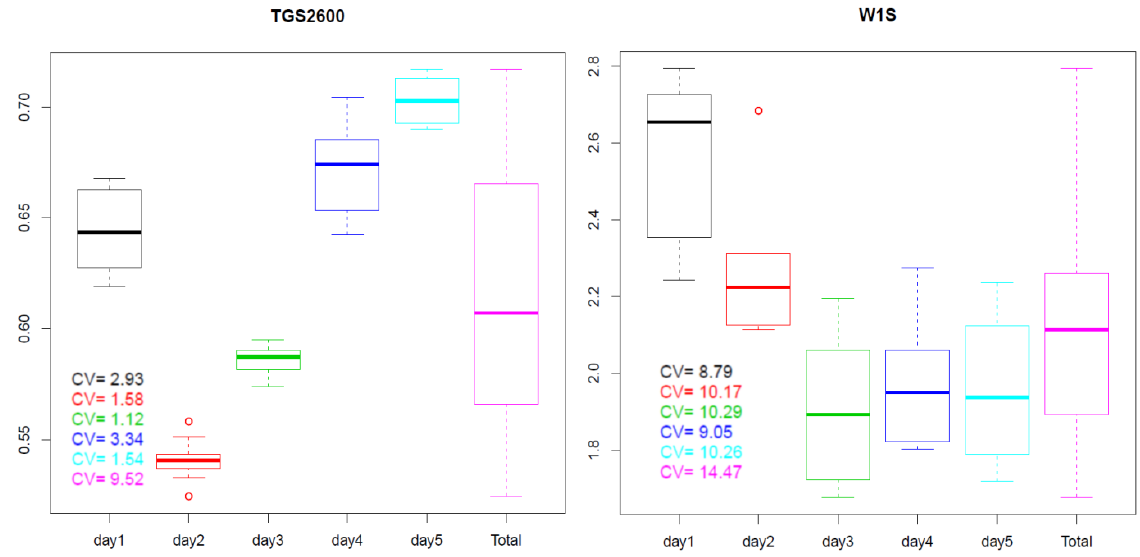
curves of Figure o